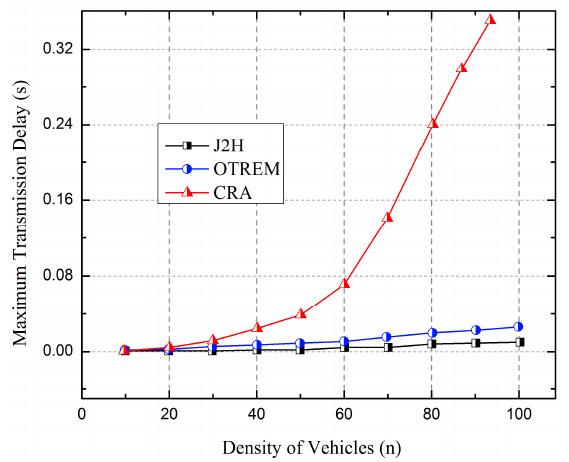
Figure 7. Analysis of maximum transmission delay in transmitting alert messages with low density of vehicles.